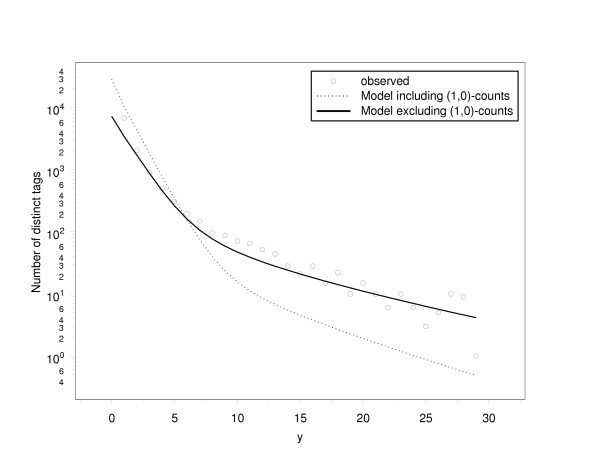
Frequencies of SAGE-genie library 1003, restricted to tags with a count of one in SAGE-genie library 430. Fitted by the bivariate gamma-poisson model with a threshold of 30 for the non-parametric component and allowing for distinct α's in the two libraries (dashed curve). The solid curve shows a fit based on the same model, but discounting tags with a count of one in either library.